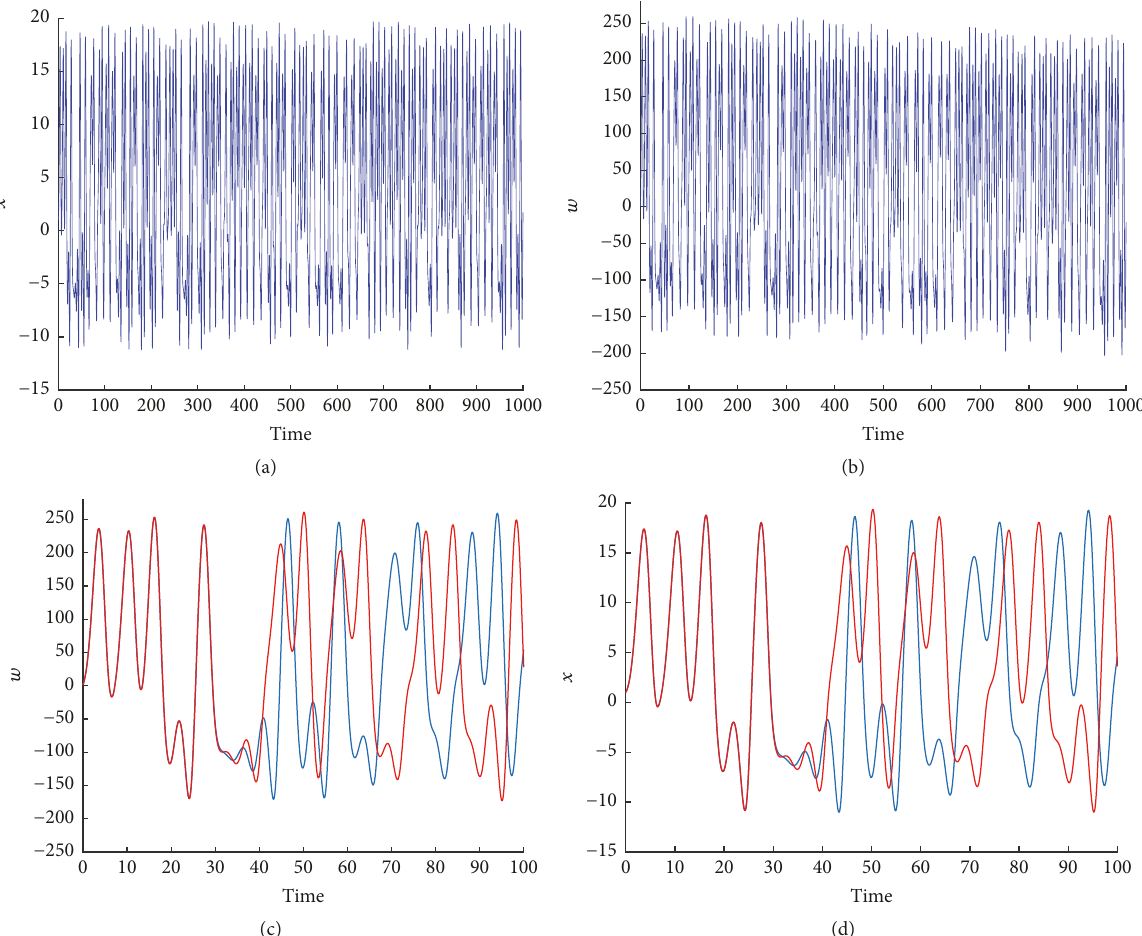
Figure 2: Time series and sensitive dependence on initial conditions (1,1,1,1) (blue) and (1.001, 1,1, 1) (red): (a) and (d) variable 𝑥 ; (b) and (c) variable 𝑤